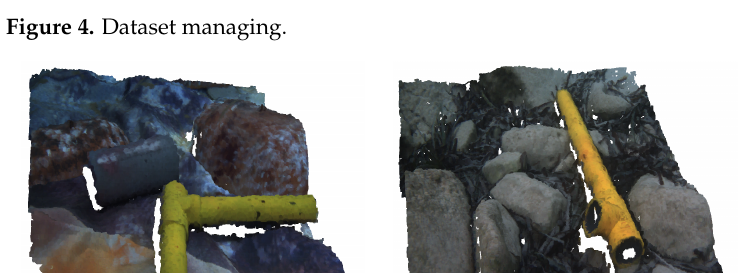
Figure 4. Dataset managing.